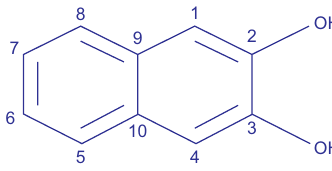
Figure 1 2,3-H ND with atom numbering 2